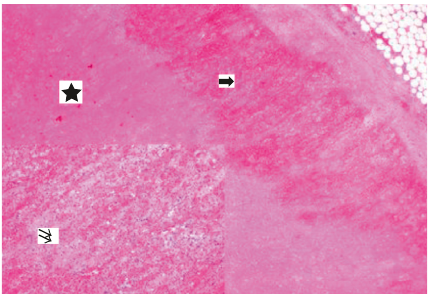
Figure 4: Haemorrhagic necrosis of the adrenal gland and com- plete necrosis of the adrenal gland. The different zones of the adrenal cortex cannot be clearly distinguished. Especially the cortex shows extensive haemorrhage (arrow). The cells are ill-defined and intermingled with fibrin exudation, showing nuclear shadows (insert, double arrow). The cellular compartment of the adrenal medulla is necrotic with intermingled fibrin exudation (star) Figure 3: Necrosis of the left hand. (haematoxylin and eosin, original magnification 4x insert, original magnification